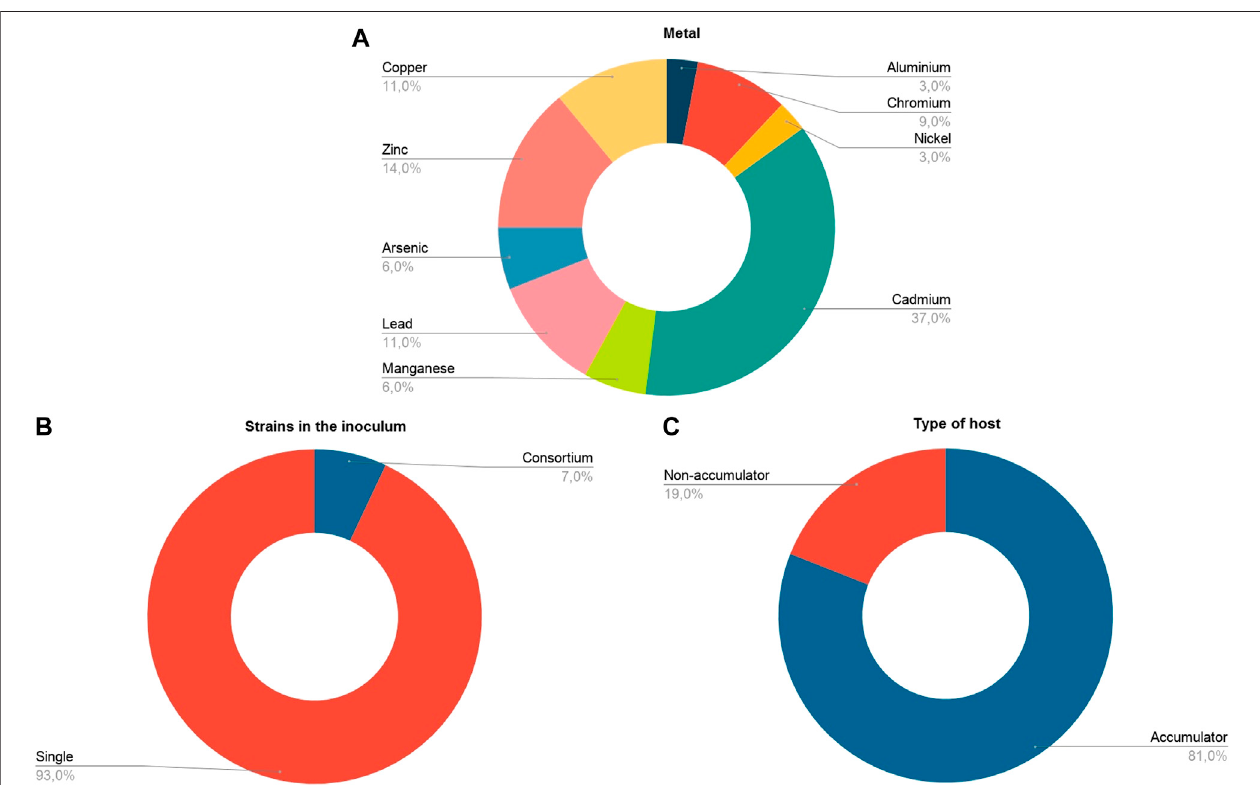
FIGURE 3 | General information about the studies included in the analysis ( n (cid:1) 27) for (A) Type of metal. (B) Strains in the inoculum. (C) Host type in terms of its metal accumulation capacity.